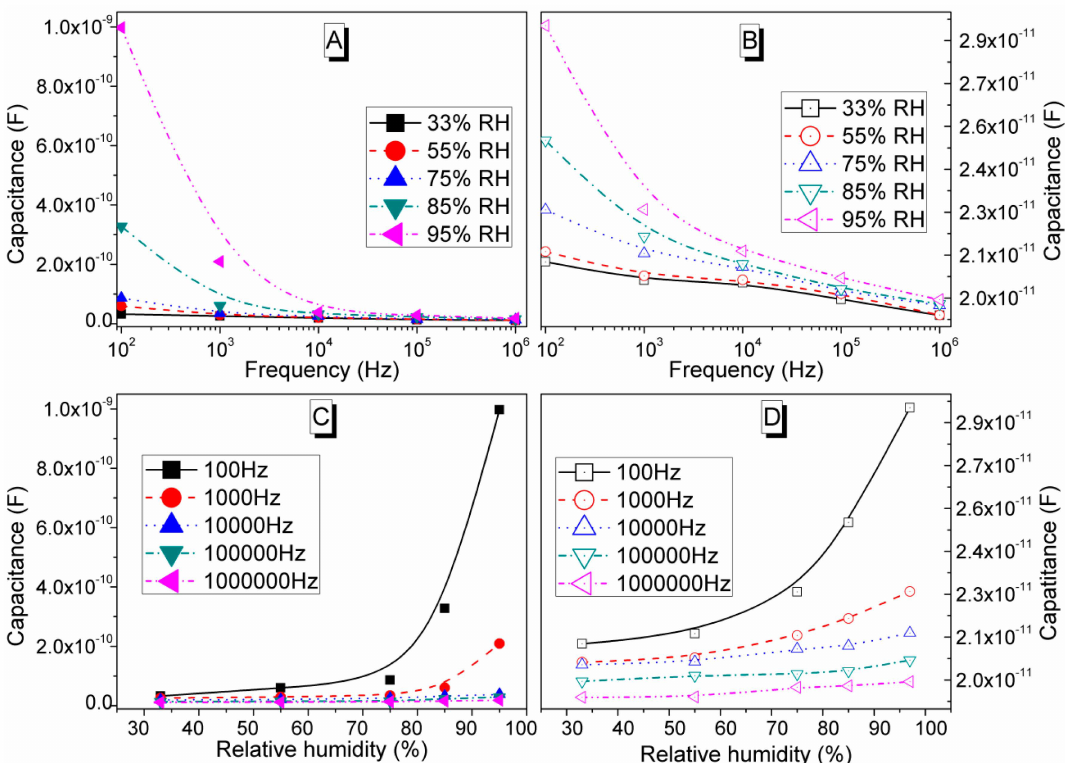
Figure 17. Frequency dependence capacitance of ( A ) sintered pellet at 1050 ˝ C (S1050) (filled symbols) and ( B ) composite film (S1050/PDMS) (opened symbols) at different humidity conditions (33, 55, 75, 85, and 95 % RH) in the frequency range of 10 2 –10 5 Hz. The capacitance response with % RH condition at different frequency points (10 2 , 10 3 , 10 4 , 10 5 and 10 6 Hz) for ( C ) sintered pellet at 1050 ˝ C (S1050) (filled symbols) and ( D ) composite film (S1050/PDMS) (opened